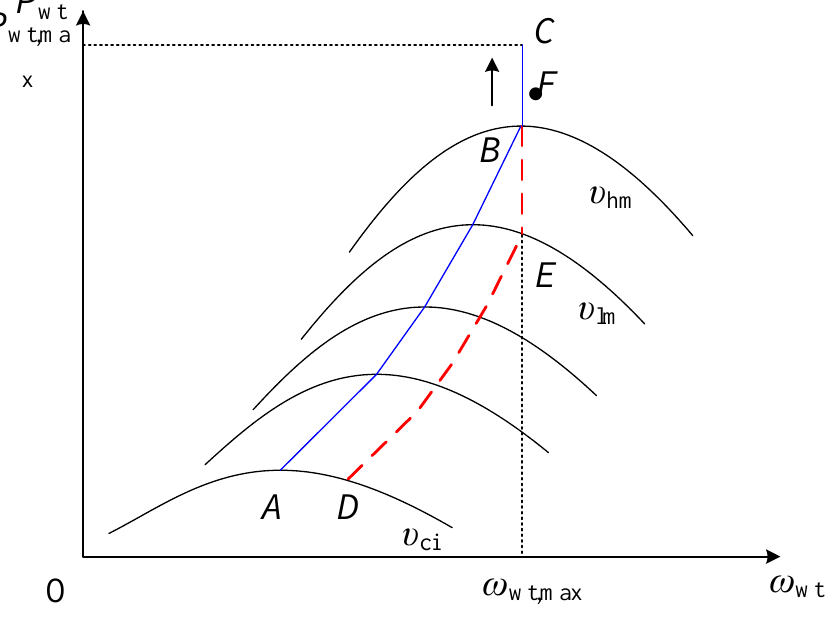
Figure 4. Captured power versus rotating speed of